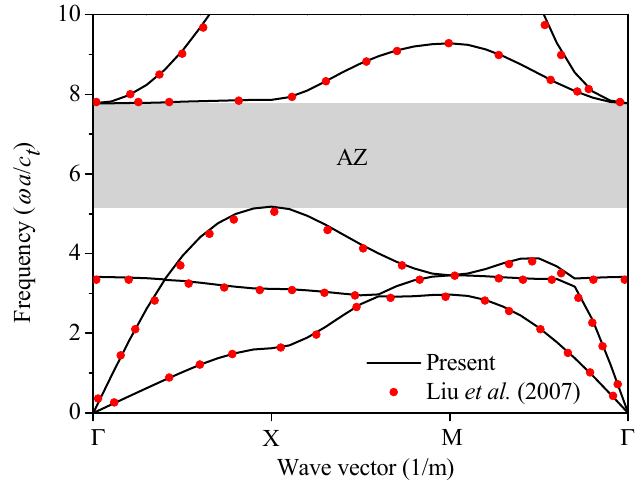
Figure 2. Dispersion curves of in-plane waves in a 2D Bragg scattering periodic structure.